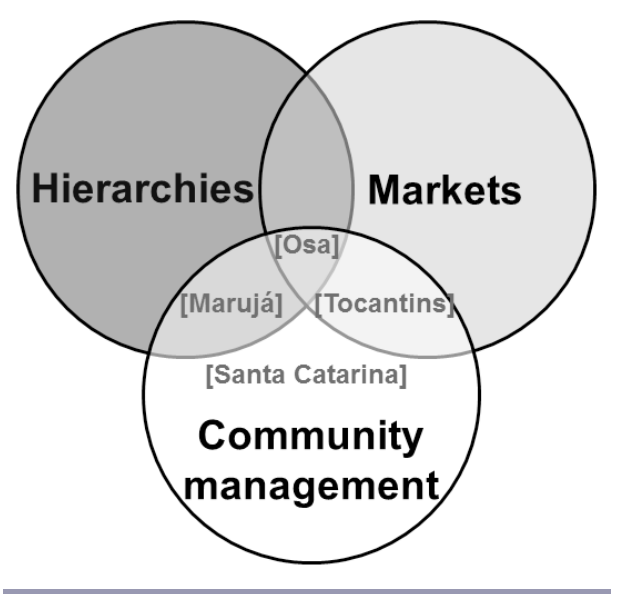
Fig. 1. Representation of community-based environmental management approaches taken in the case studies (one pure and three hybrid